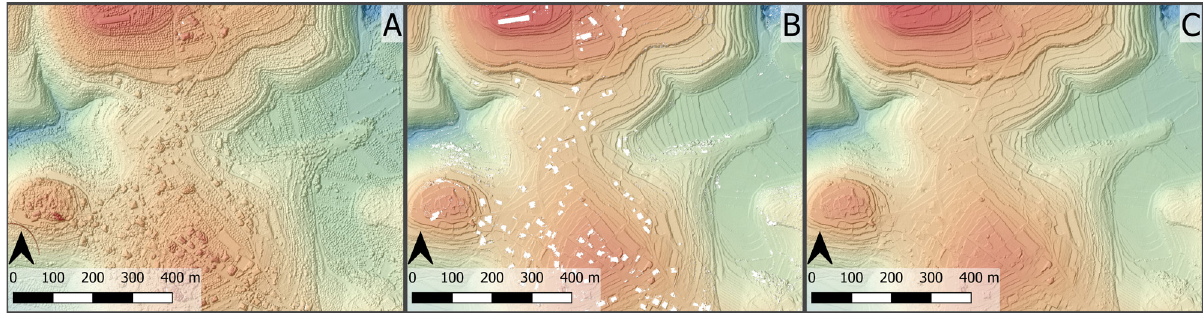
Figure 9: Effects of the ground classification and the interpolation using the example of a small section. A: Digital Surface Model, which includes buildings and vegetation. B: DTM, only ground points are included. The artificial terraces become clearly visible. C: DTM after gaps were filled by